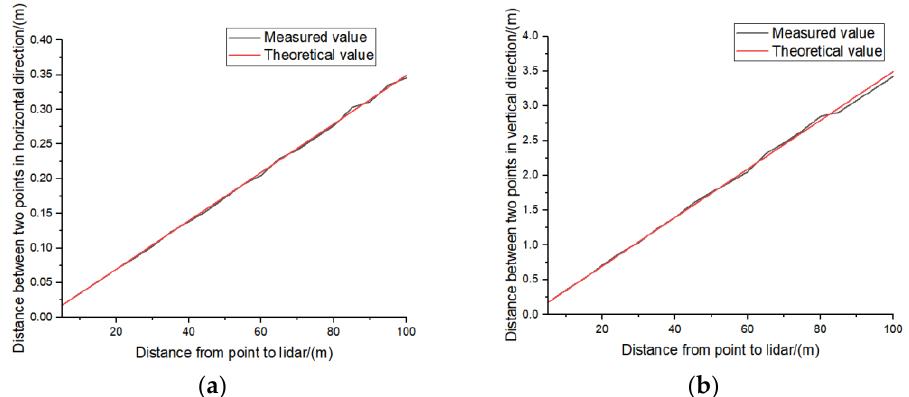
Figure 9. Theoretical and measured values of the distance between two points in the horizontal and vertical directions: ( a ) horizontal direction; ( b ) vertical direction.